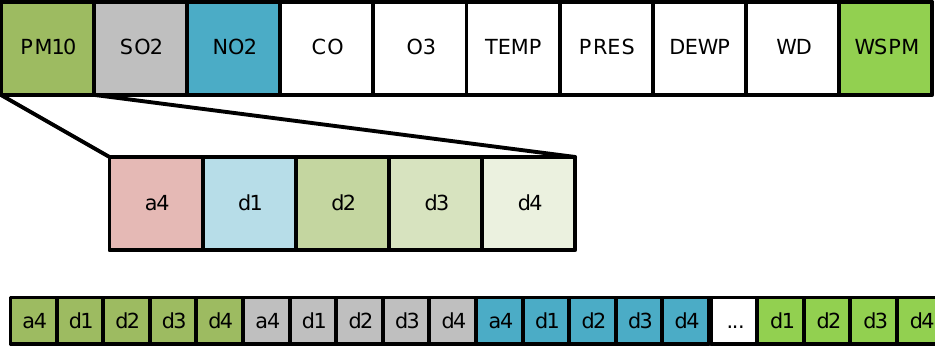
Figure 7. Structure of the decomposed input